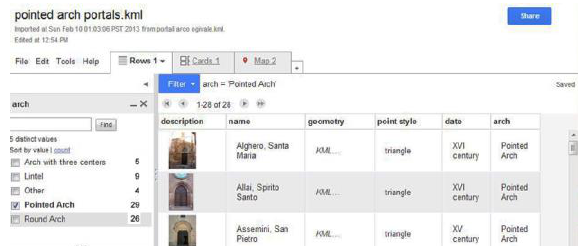
Figure 4. Screenshot of the table created by Google Fusion Tables.